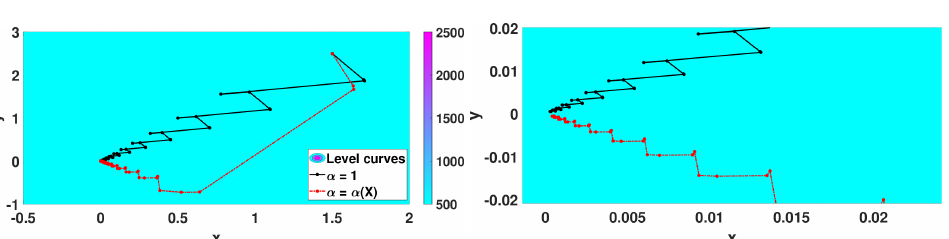
Figure 8. Iterates for f 1 ( Ψ 2 ( X ))